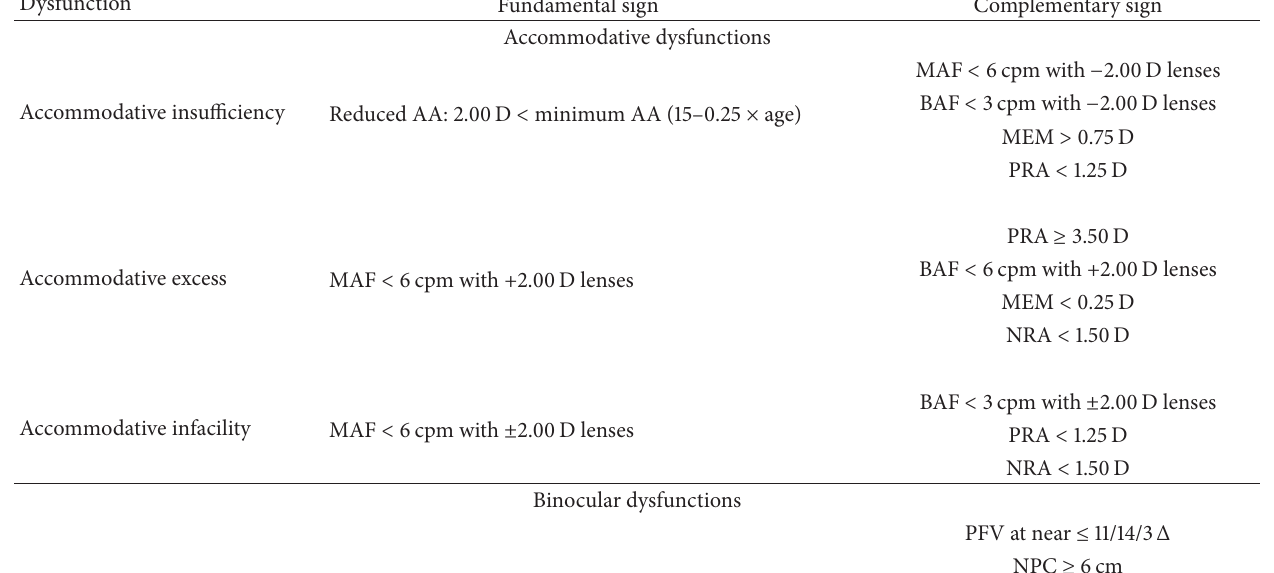
Table 1: Clinical signs used in the study for diagnosing accommodative and binocular anomalies (AA: accommodative amplitude; MAF/BAF: monocular/binocular accommodative facility; MEM: monocular estimate method; PRA/NRA: positive/negative relative accommodation; PFV/NFV: positive/negative fusional vergence; NPC: near point of convergence; VF: vergence facility; Δ : prism diopters; D: diopters; cpm: cycles per minute; BO: base-out; BI: